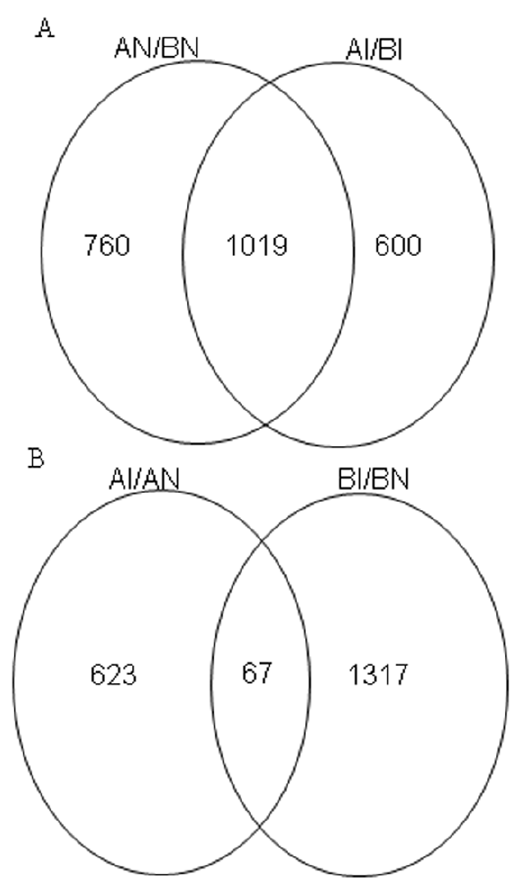
Figure 2. Venn diagram showing the number of differentially expressed genes overlapped in different comparisons. A: Number of genes overlapped between lines A and B of inoculated and non-inoculated birds. B: Number of genes overlapped between inoculated birds and non-inoculated within A line and B line.